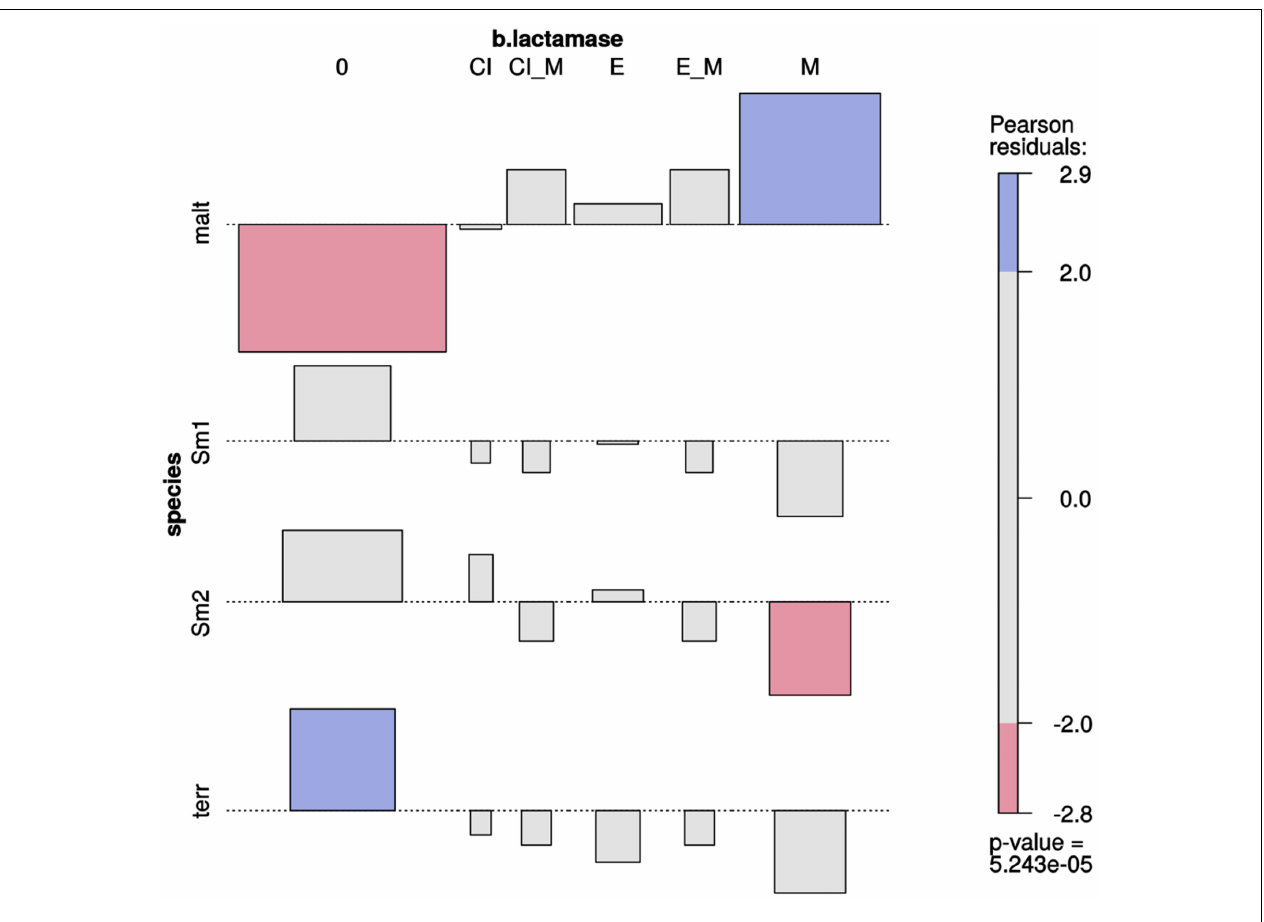
FIGURE 5 | Two-way association plot for the categorical variables species and β -lactamase production phenotype and Stenotrophomonas species containing > 10 Mexican environmental isolates. The bars on the plot represent the Pearson residuals, the color code and the height of the bars denote the significance level and magnitude of the residuals, and their widths are proportional to the sample size. The β -lactamase codes are as follows: 0 = no β -lactamase activity detected; CI = clavulanate-inducible class A or class C (AmpC) cephalosporinase; CI_M = clavulanate-inducible cephalosporinase plus metallo β -lactamase (MBL); E = extended-spectrum β -lactamase (ESBL); E_M = ESBL plus MBL; M = MBL. Species codes are as defined in Figure 3